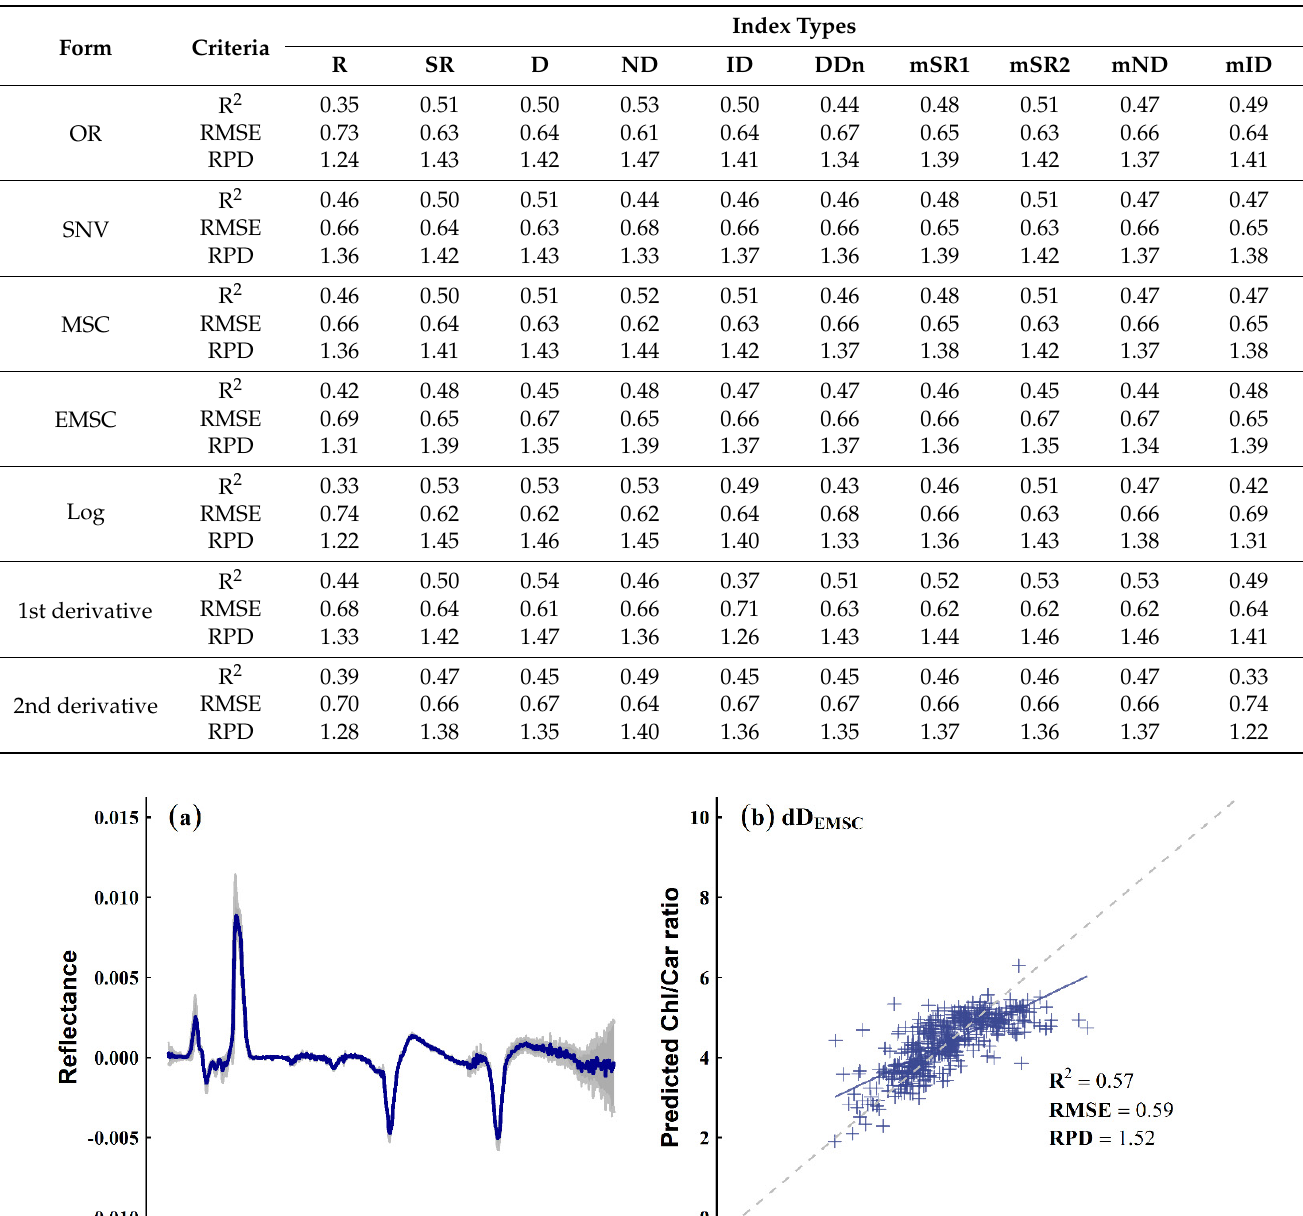
Table 4. The performance of different types of indices developed for the estimation of the chlorophyll (Chl)/carotenoid (Car) ratio using various spectral transformations.